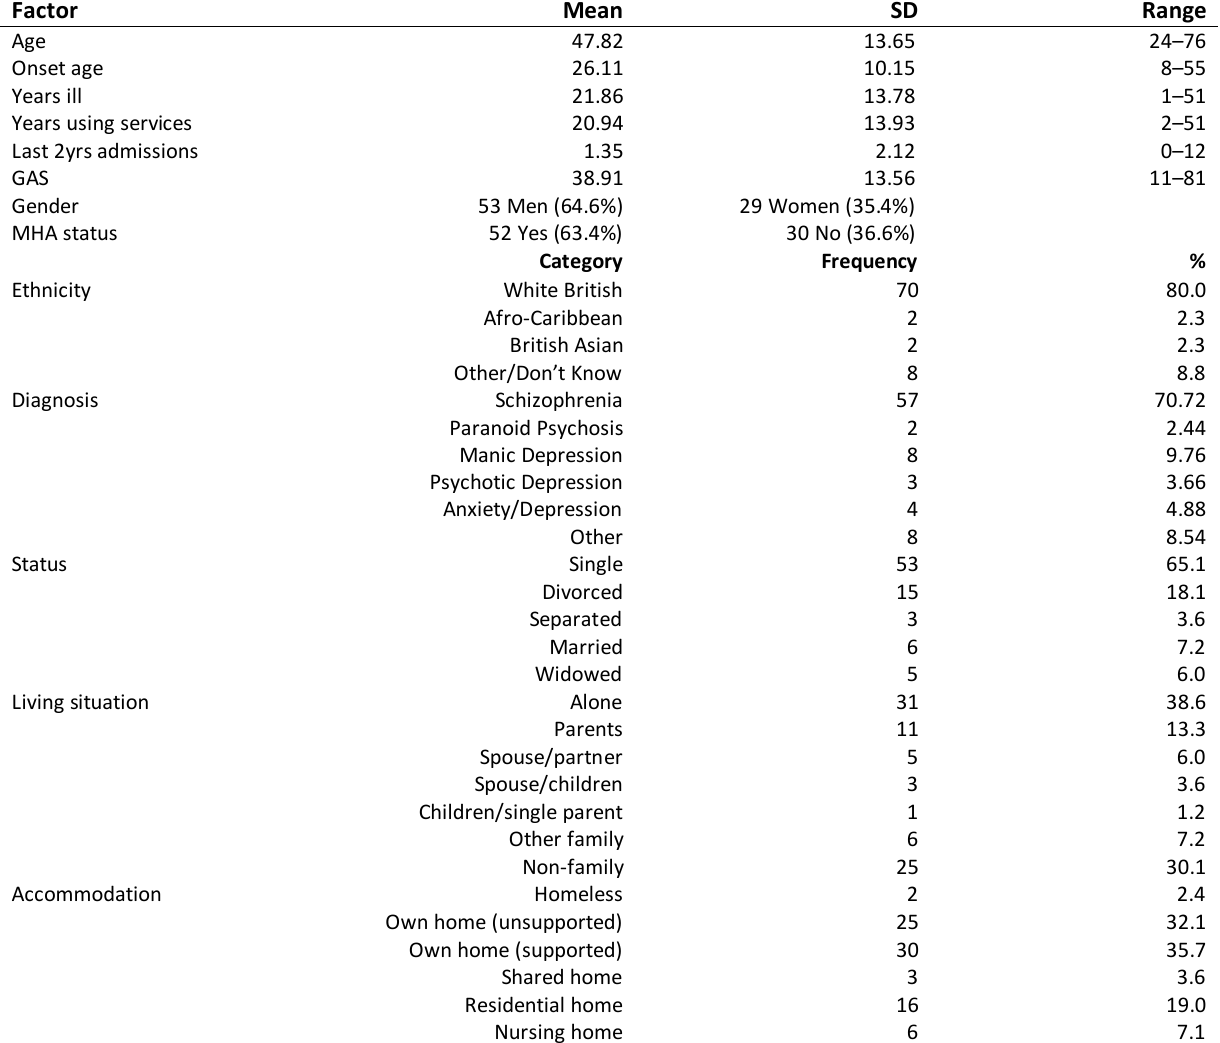
Table 2. SNQ reference population